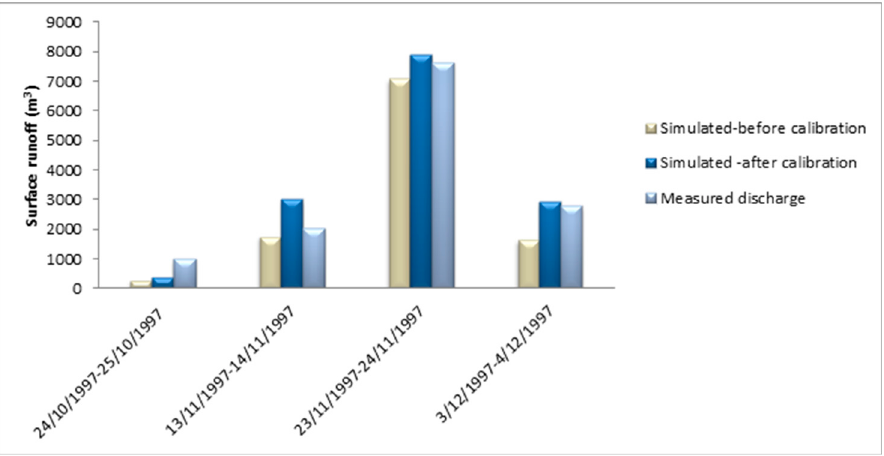
Figure 2. Observed and CN simulated (before and after calibration) surface runoff (m 3 ).